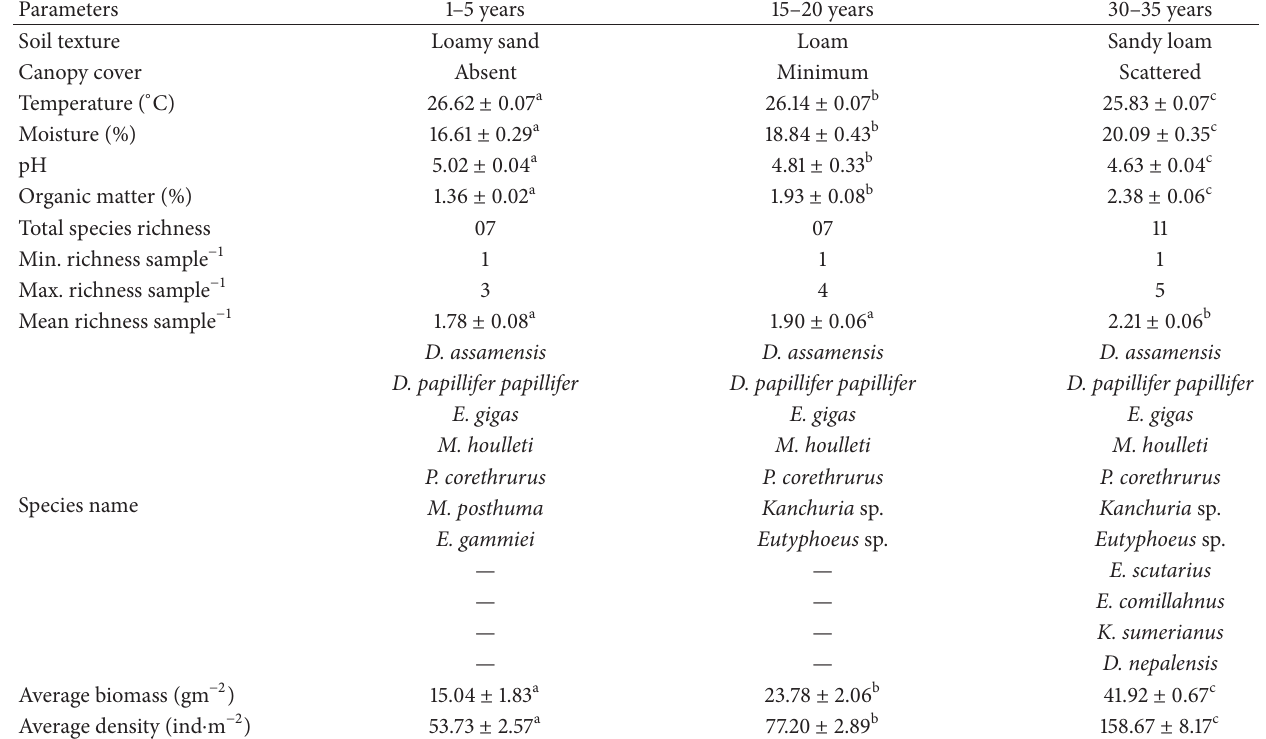
Table 4: Comparison of soil physicochemical and earthworm community parameters among different age group of pineapple plantations of